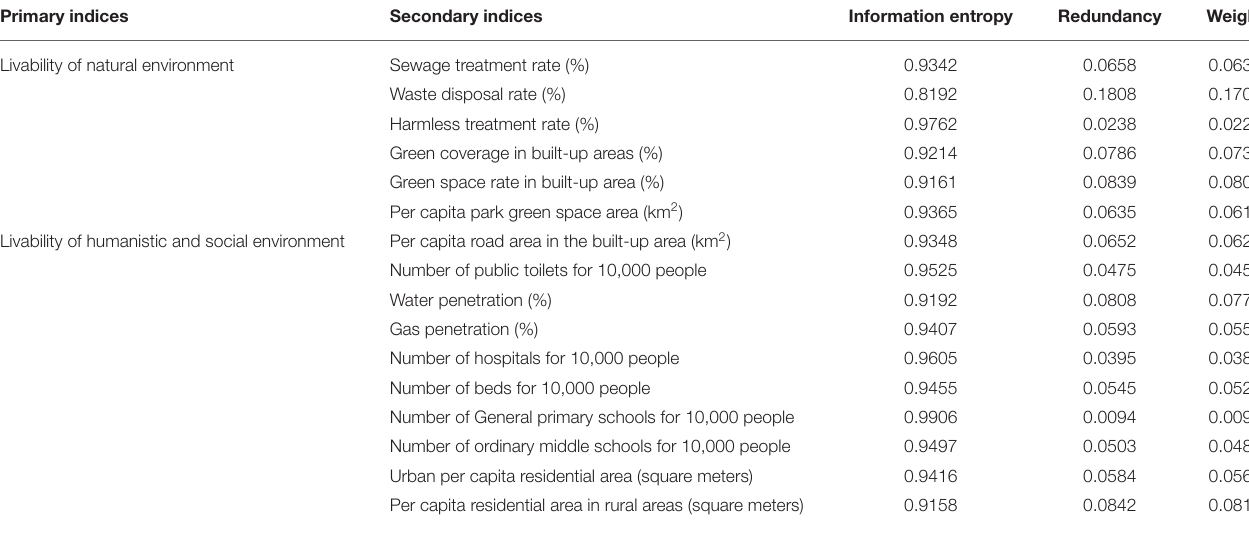
TABLE 2 | Evaluation index system of ecological livability of 812 small towns, Chongqing. Primary